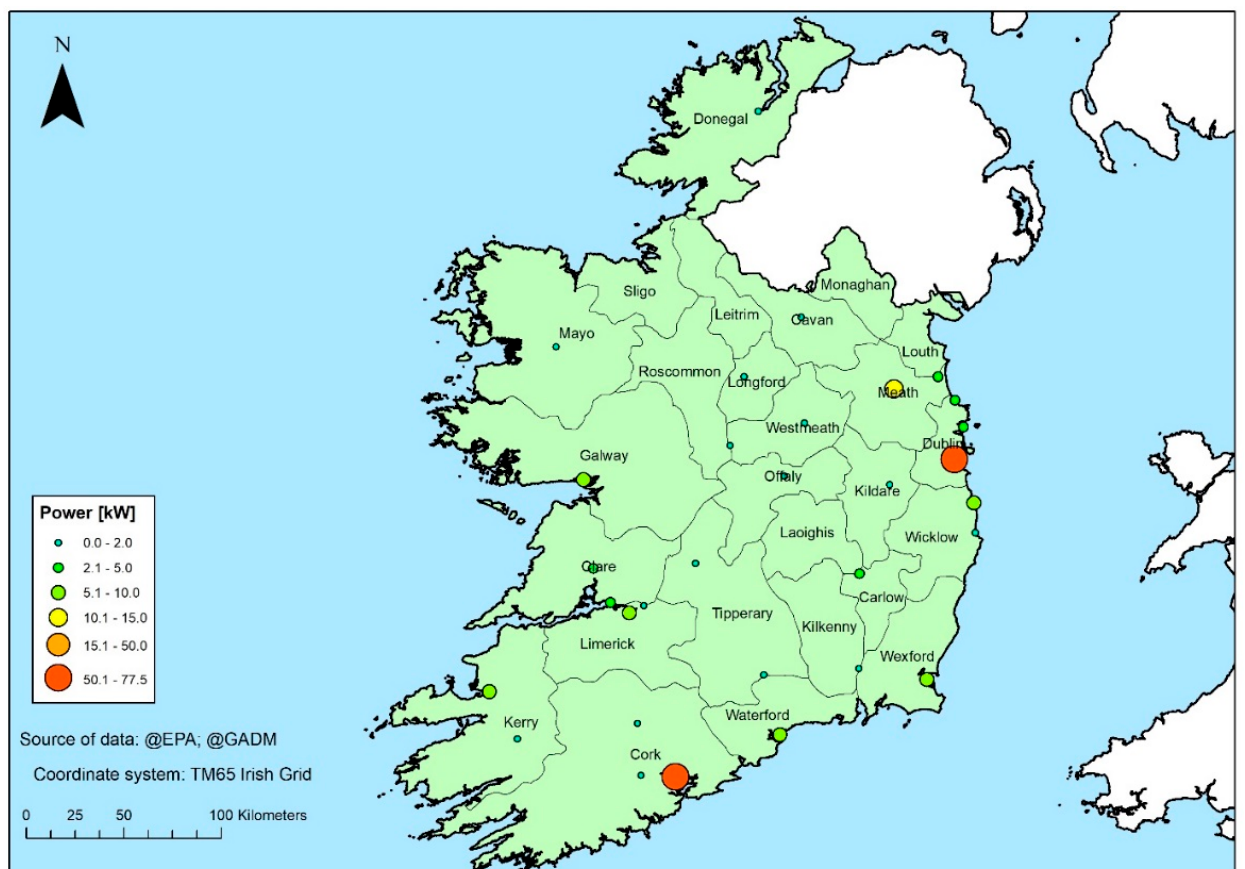
Figure 5. Spatial distribution of MHP potential of wastewater treatment plant outfalls in Ireland. A total of 3206 kW of power at wastewater treatment plant outfalls in the six countries was estimated on the basis of Equation (2) and corresponding population data. The low- 𝑦 = 4.4222 × 10 (cid:2879)(cid:2873) 𝑥 − 1.4565 head inherent in most wastewater treatment plant outfalls resulted in a relatively low energy potential from this sector in comparison with drinking water, amounting to an annual total of 28.0